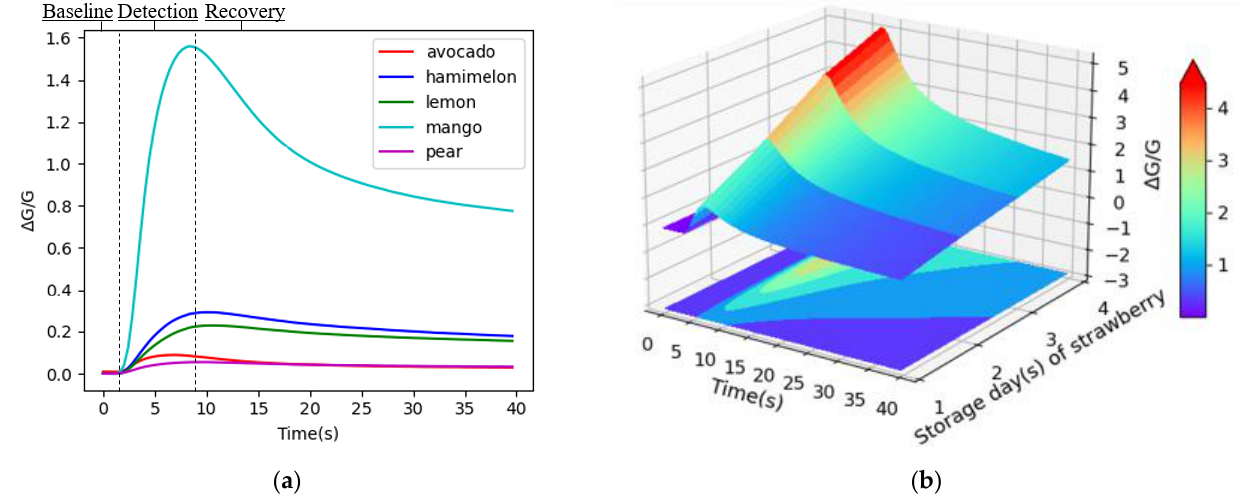
Figure 2. The relative conductance response of the gas sensor to fruit: ( a )the relative conductance response of the MQ7 sensor to different kinds of fruit odors, which consists of baseline region, detection region, and recovery region; ( b ) the relative conductance response of the MQ7 sensor to peeled strawberry on different storage days.